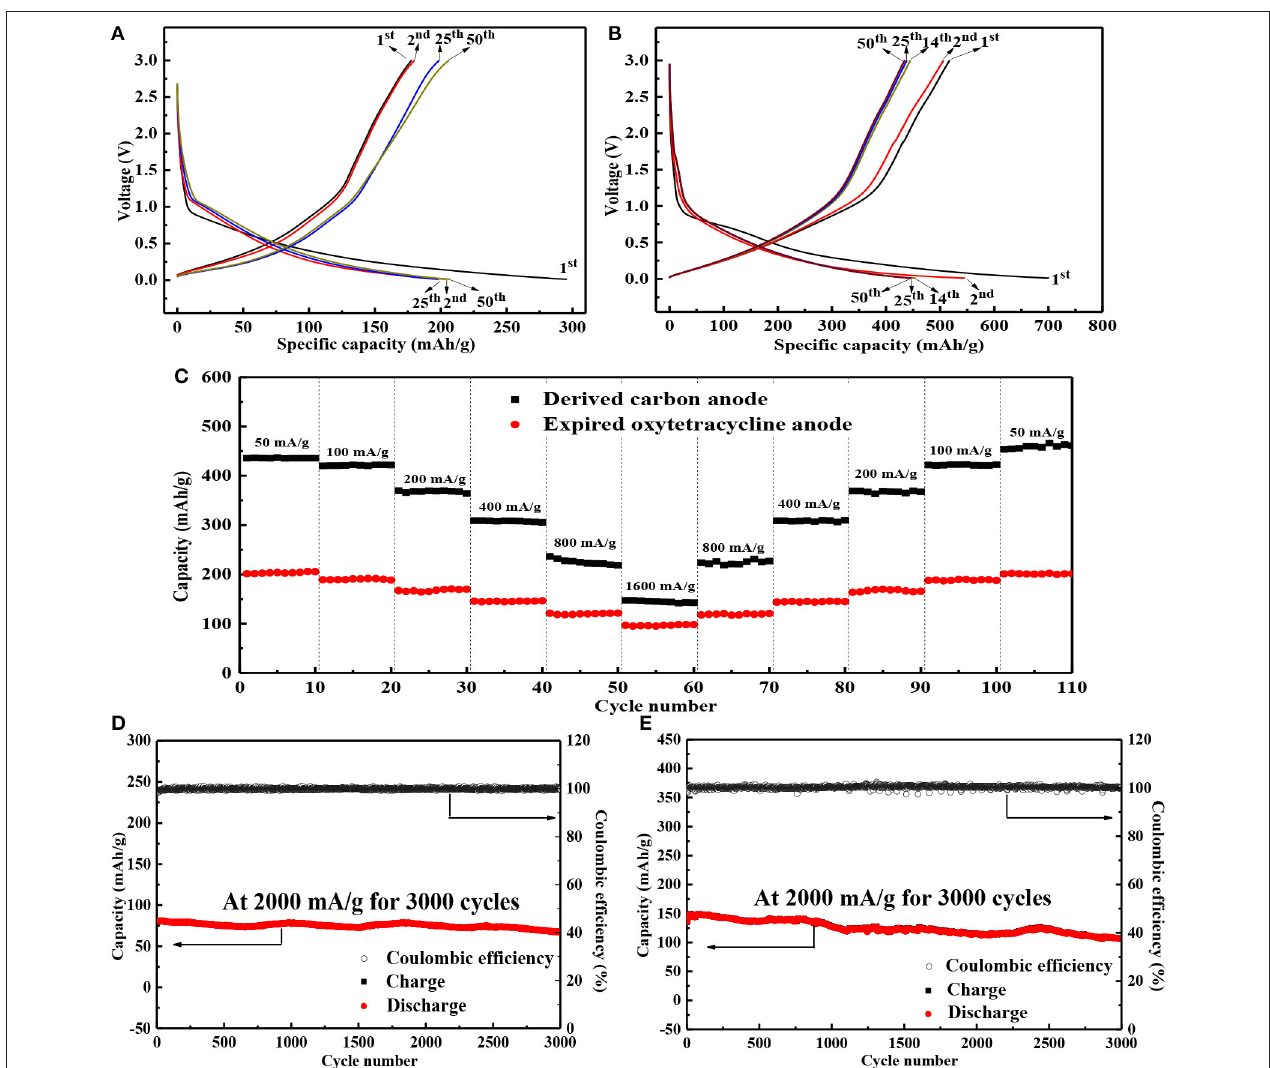
FIGURE 6 | Representative charge/discharge profiles of (A) expired oxytetracycline anode and (B) expired-oxytetracycline-derived carbon anode at 50 mA/g, (C) the rate performances of both anodes and the cyclic performances of (D) expired oxytetracycline anode and (E) expired-oxytetracycline-derived carbon anode.